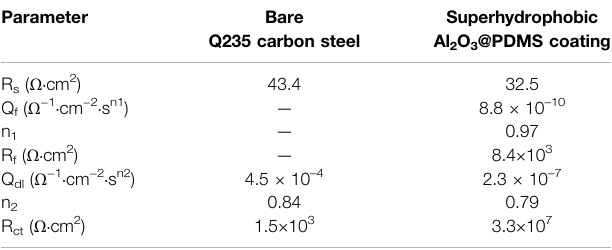
TABLE 1 | Electrochemical parameters for the EIS fi tting results of bare Q235 carbon steel and superhydrophobic Al 2 O 3 @PDMS coating. Parameter